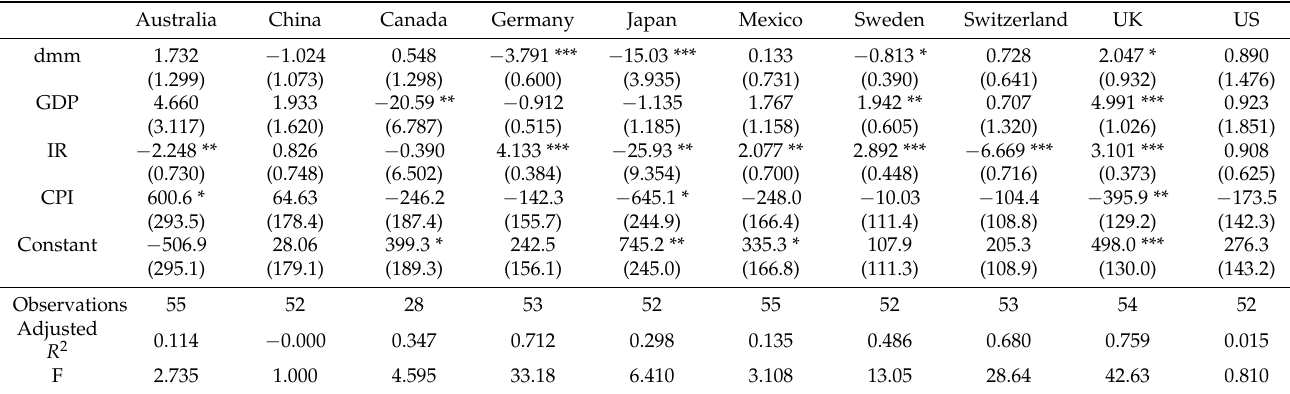
Table A19. Panel Regression OM Model for